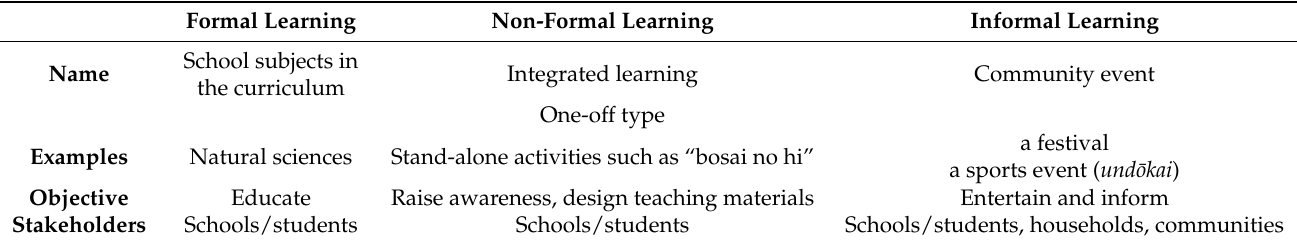
Table 4. Disaster Resilience Education programs in